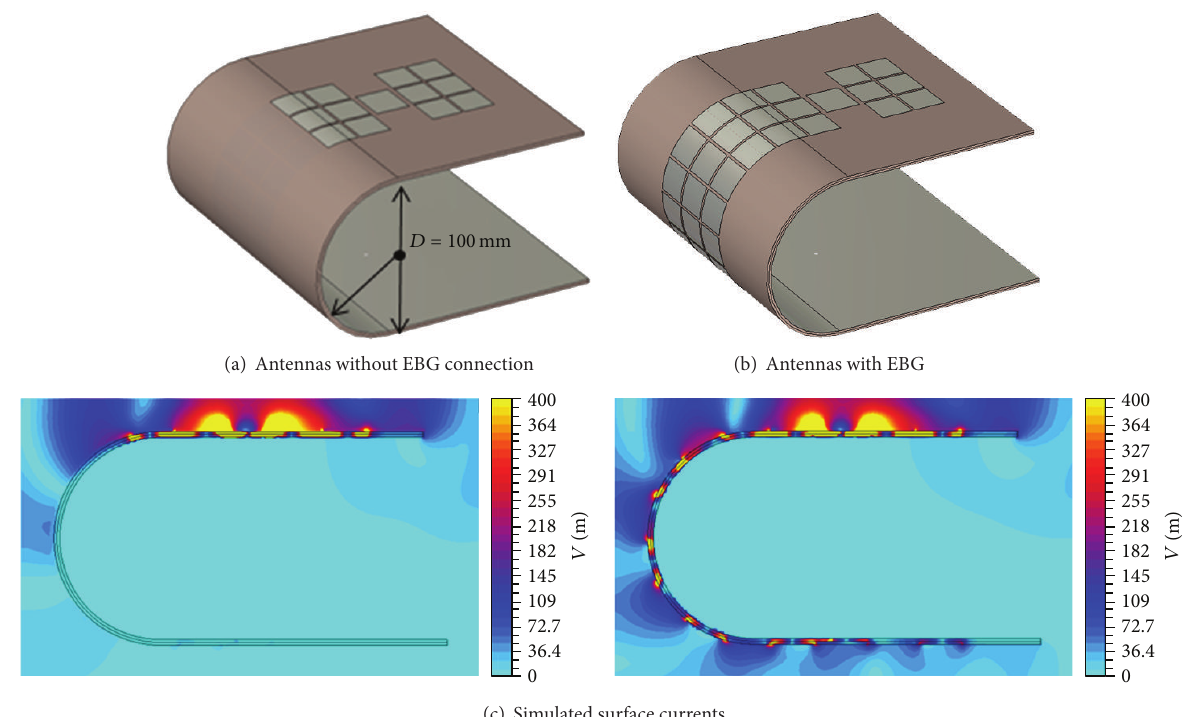
Figure 12: Antennas bent on a radius of 100mm.